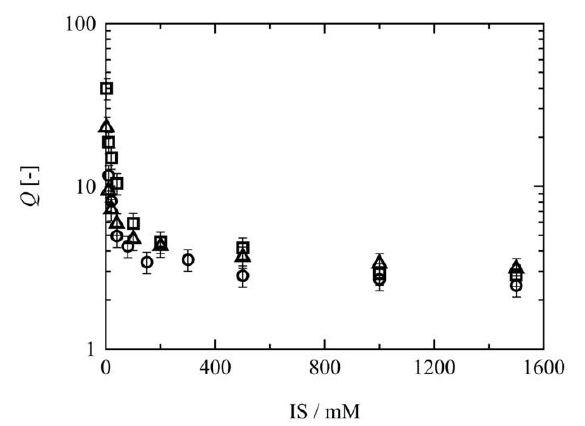
Figure 4. Ionic strength dependences of the swelling ratios of the Tetra-PAA-PEG gels in NaCl solutions: 10 K Tetra-PAA-PEG gel (squares), 20 K Tetra-PAA-PEG gel (circles), and 40 K Tetra-PAA-PEG gel (triangles). The pH values of the outer solutions for the 10 K, 20 K, and 40 K Tetra-PAA-PEG gels were 8.6, 9.7, and 8.0, respectively.